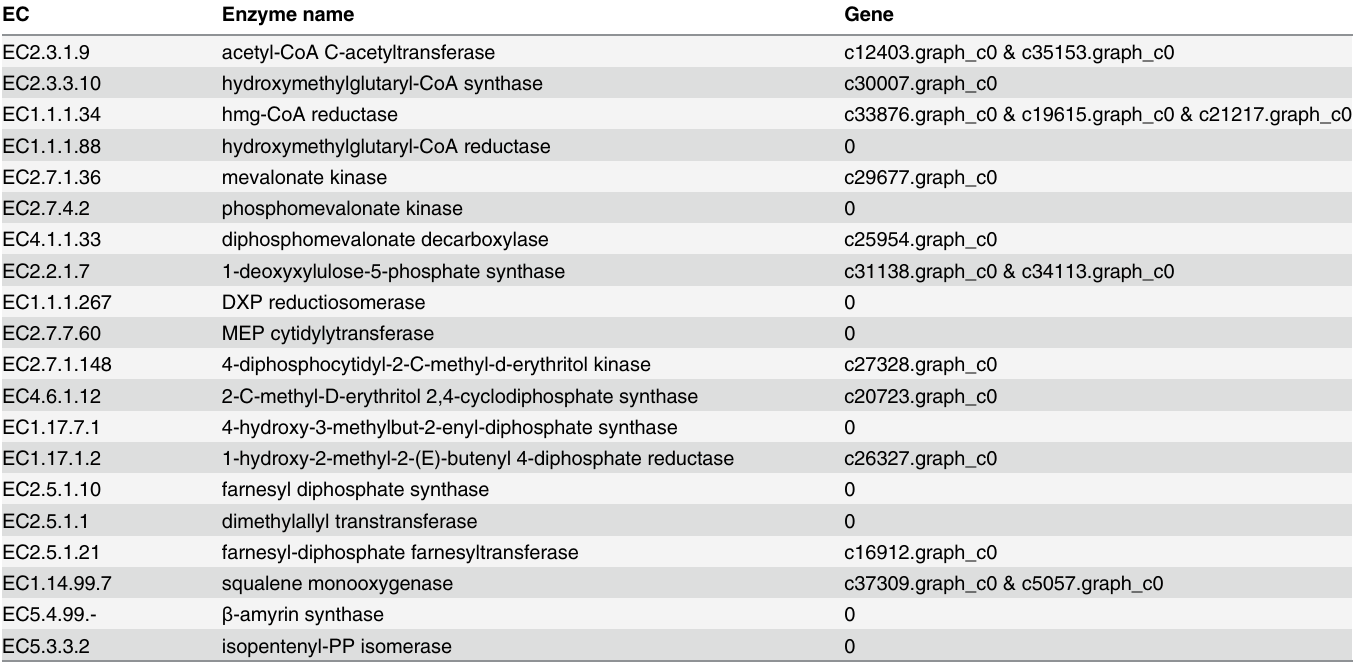
Table 2. Enzymes related to glycyrrhizic acid metabolic